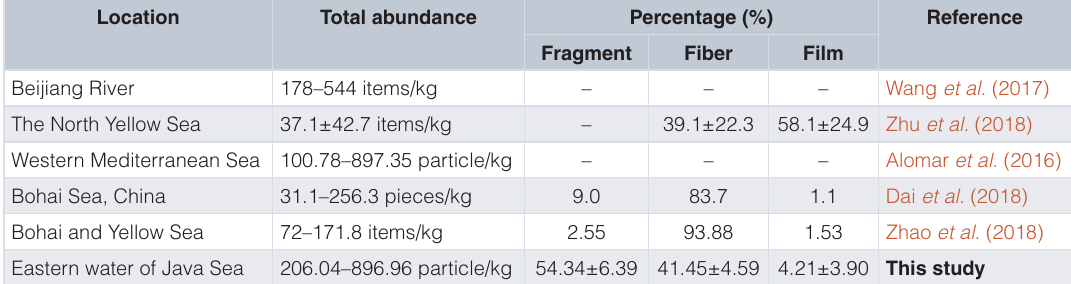
Table 1. The abundance of microplastics in the sediment reported from this and other